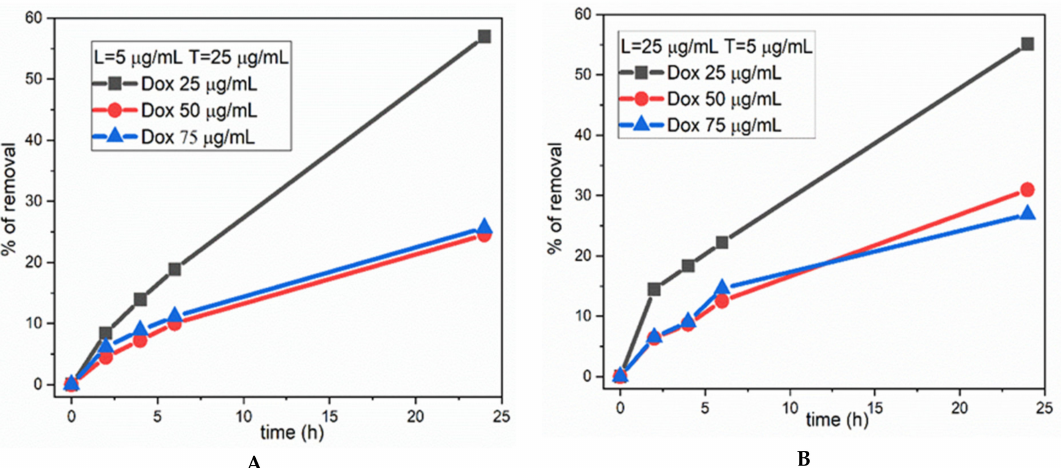
Figure 5. Percentage of removal of doxorubicin at different concentrations, varying the ratio between laccase and TEMPO: ( A ) laccase 5 mg/mL, TEMPO 25 mg/mL; ( B ) laccase 25 mg/mL, TEMPO 5 mg/mL; the concentrations of doxorubicin were 25, 50, and 75